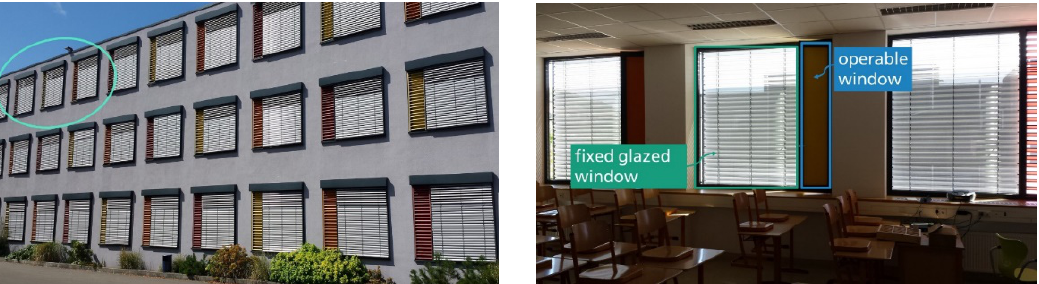
Figure 4. Left : View of the east façade of the school building. The examined room is marked in orange. Right : Interior view of the window front. The right wings of the windows can be opened, and permanent sun and rain protection is installed in front of them [Fraunhofer ISE].